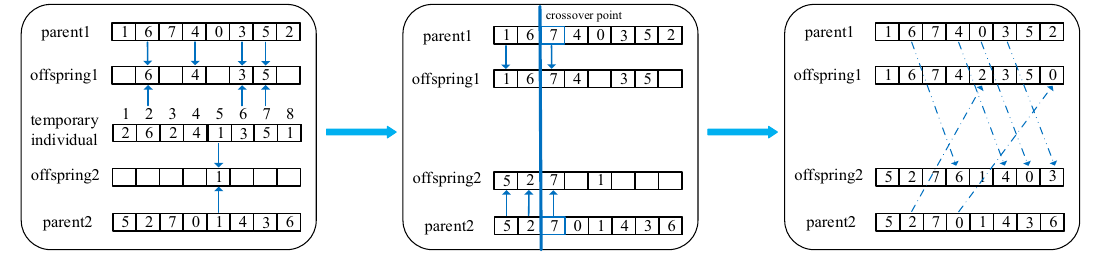
Fig. 9 Process of ISJOXII